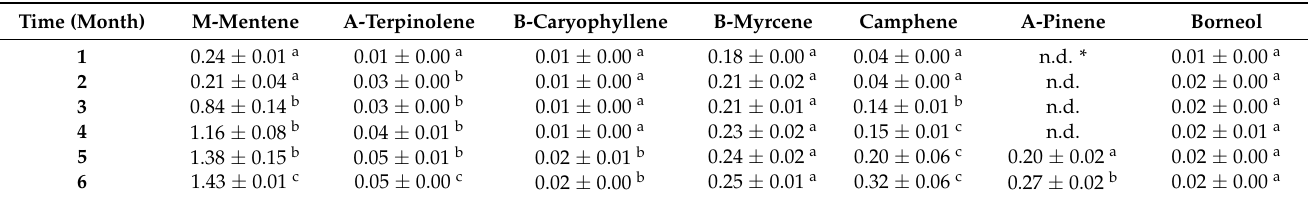
Table 4. Concentration ± SD (mg/Kg) of volatile compounds from rosemary herb quantified in flavored virgin olive oil (ROO) during the six months of